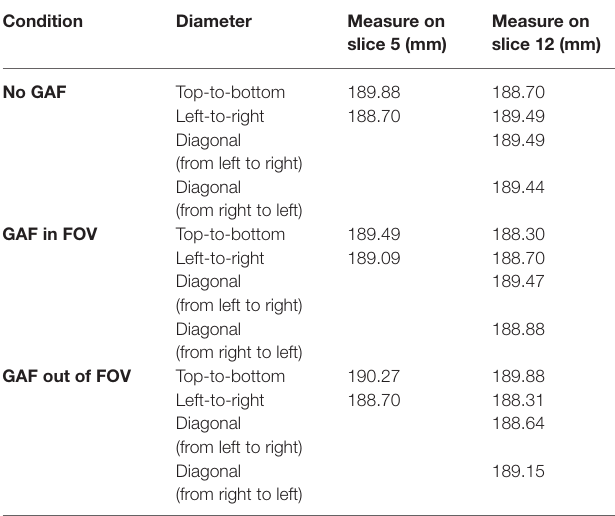
TABLE 1 | Results from the Geometric accuracy test (diameter). Condition